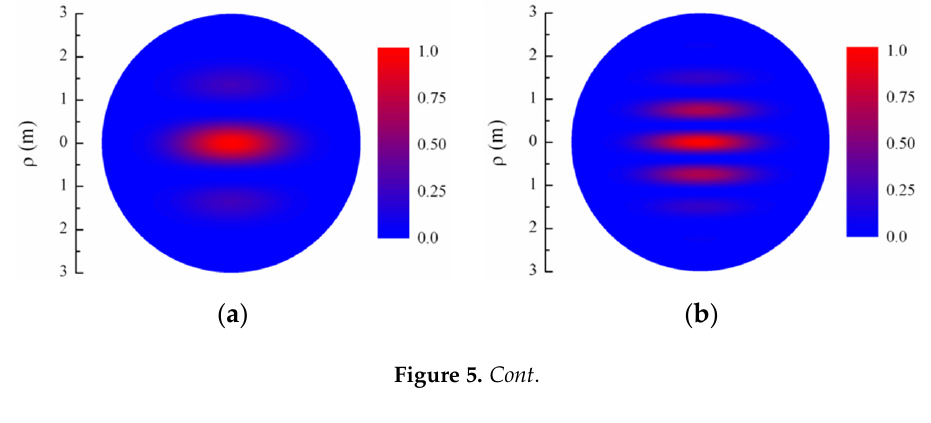
Figure 5. Cont . Figure 5. Cont .